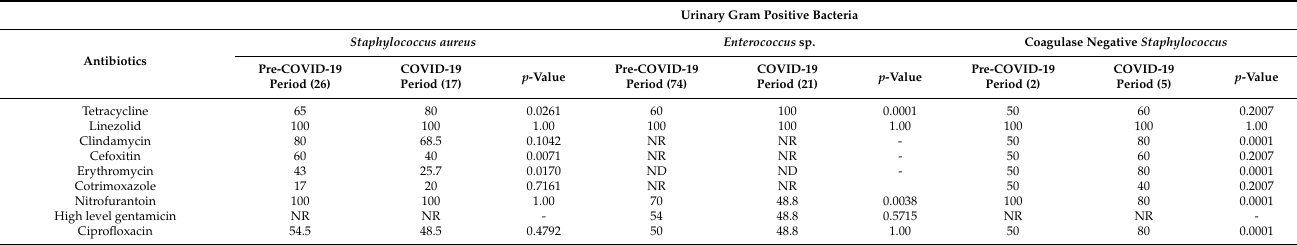
Table 6. Comparison of percentage antimicrobial susceptibility pattern of Gram positive bacteria in urine samples between pre-COVID-19 and COVID-19